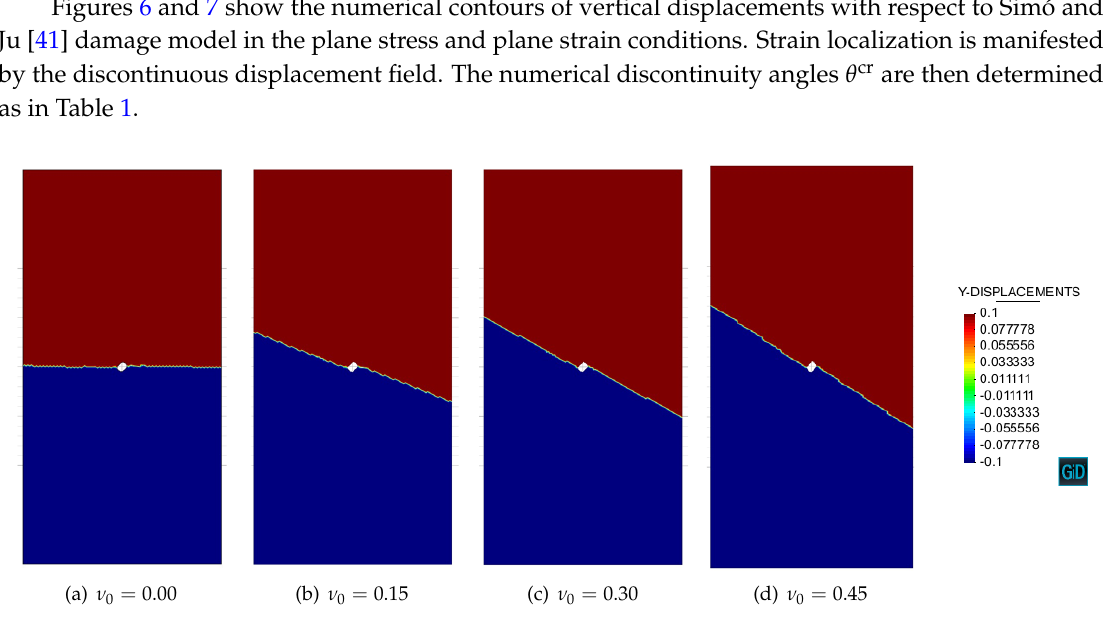
Figure 6. Uniaxial tension of a perforated strip: Simó and Ju [41] damage model in the plane stress condition.